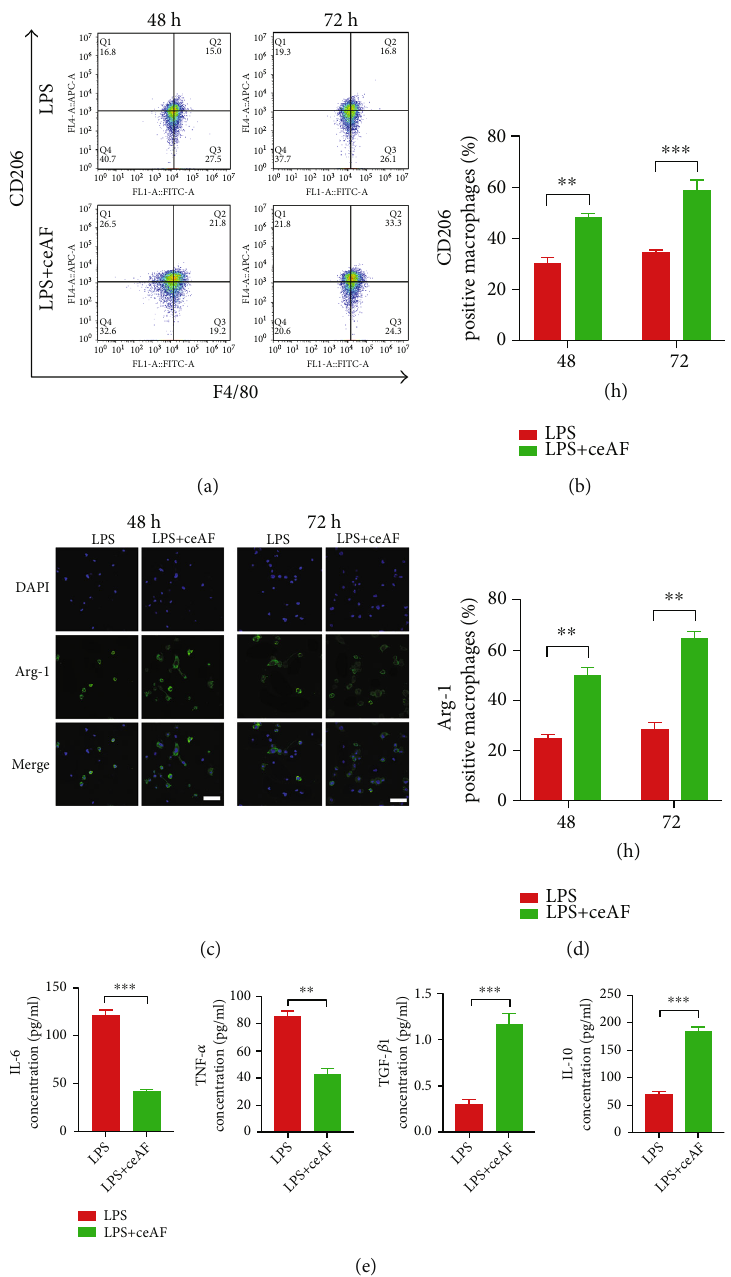
Figure 2: ceAF augments M2 macrophage polarization in vitro . (a) Flow cytometric analysis of M2 macrophage proportions after ceAF treatment in a time-dependent manner. (b) The quanti fi ed results of (a) are presented in a bar chart. (c) Immuno fl uorescence staining indicated that Arg-1 + cells were treated with LPS and LPS+ceAF at 48 and 72 h. Scale bar: 40 μ m. (d) The quanti fi ed results of (c) are presented in a bar chart. (e) ELISA detection results of IL-6, TNF- α , TGF- β 1, and IL-10. n = 3 , Mean ± SEM . ∗∗ P < 0 : 01 , ∗∗∗ P < 0 : 001